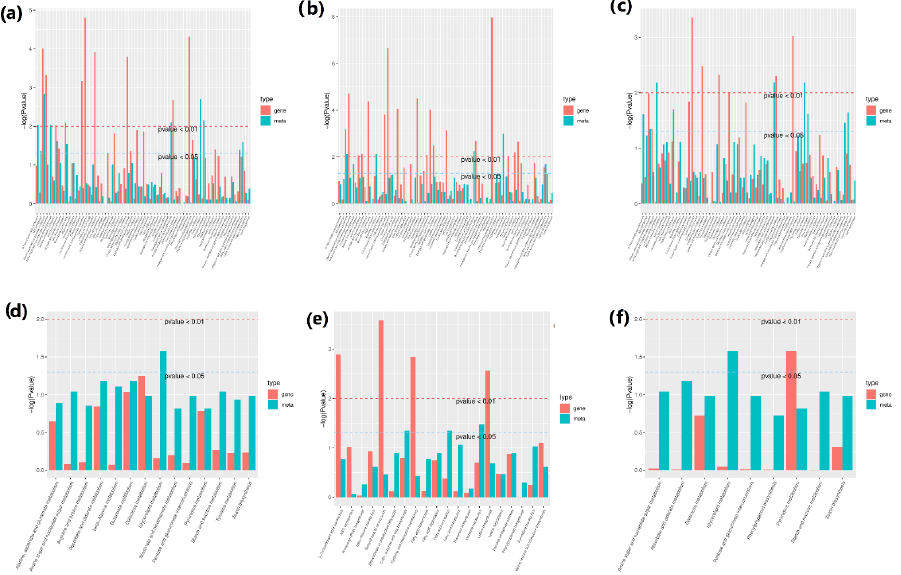
Figure 9. Conjoint analysis of the transcriptome and metabolome for the abundance of DEGs and DAMs involved in the production and regulation of glucose-1-phosphate (G1P), uridine 5 ′ -diphospho-D-glucose (UDP-G1c), and 2-deoxyribose 1-phosphate (dR-1-P) in the CK and seedling samples that were NaCl-pre-treated for 0.5, 1, and 1.5 h in cotton seedlings, illustrating the KEGG pathway enrichment of DEGs and DAMs. ( a ) CK-vs.-N0.5, ( b ) CK-vs.-N1, ( c ) CK-vs.-1.5, ( d ) N0.1-vs.-N1, ( e ) N0.5-vs.-N1.5, and ( f ) N1-vs.-N1.5.